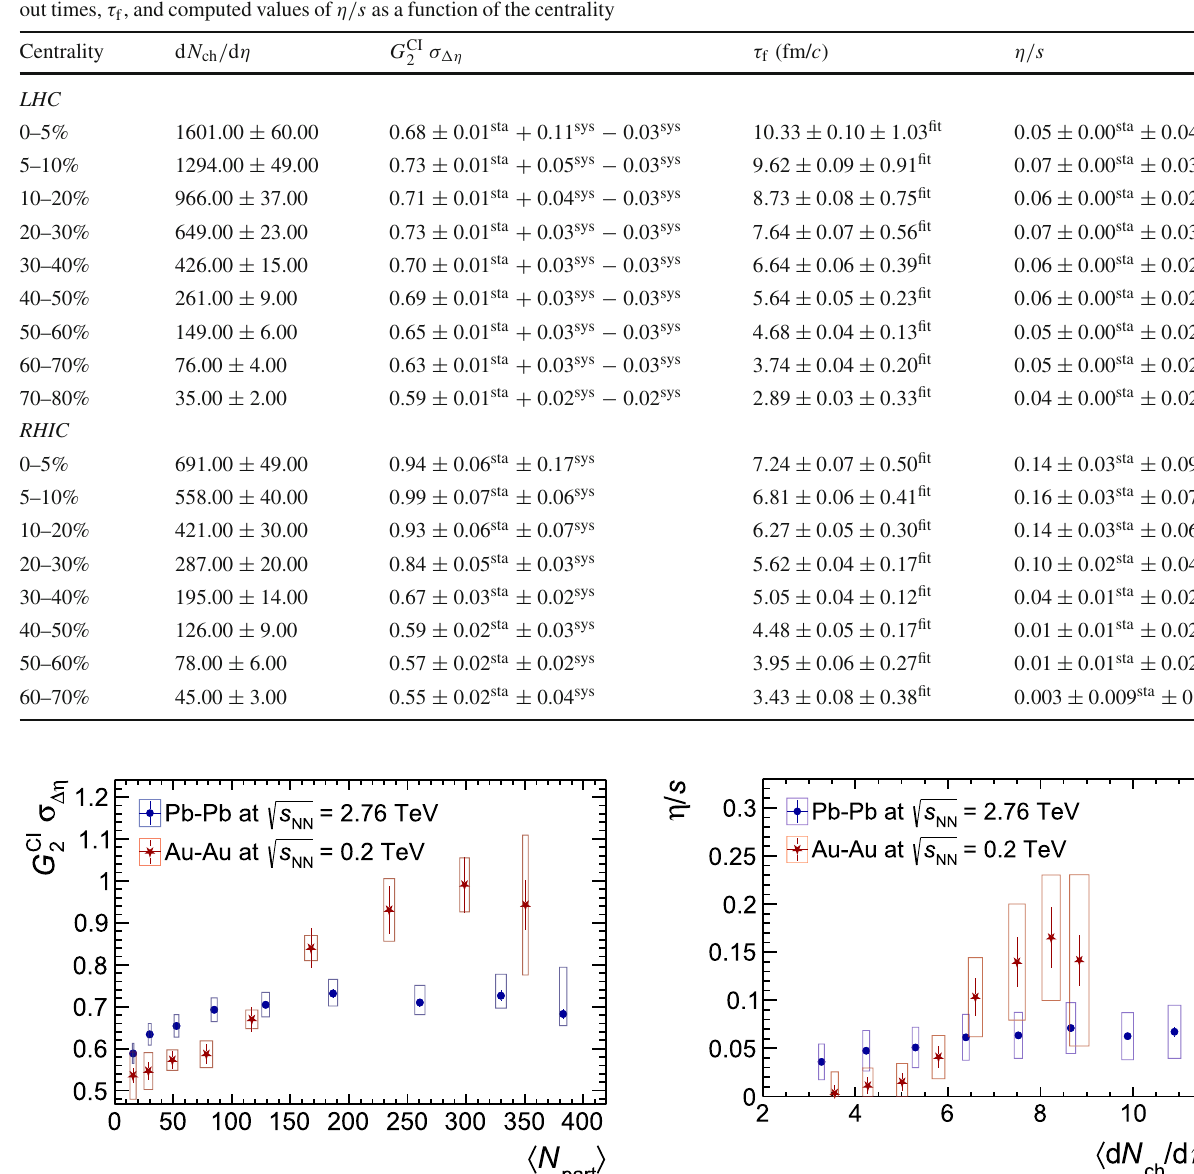
correlator, interpolated freeze- 2